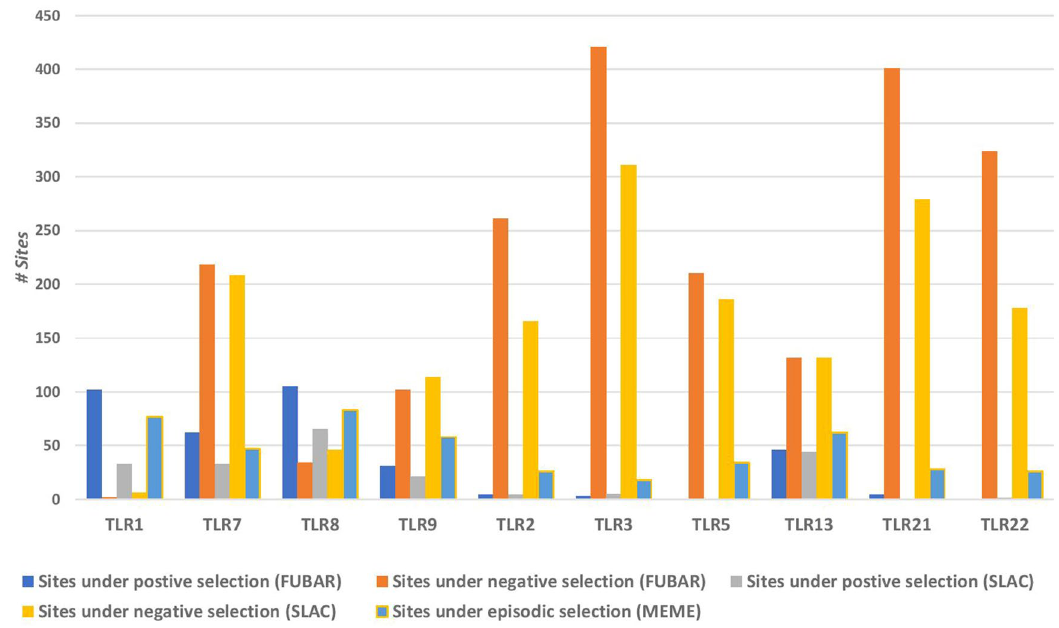
Figure 2. Bar graph representing the number of residues experiencing negative and positive selection for each of the selected TLR lineages. FUBAR and SLAC have been used to detect the sites under negative selection and pervasive positive selection and MEME has been used to detect the sites under positive episodic selection. TLR1, 7, 8 and 9 show a higher number of positively selected sites as compared to the negatively selected ones, while a vice-versa trend is seen for TLR2, 3, 5, 13, 21 and 22.